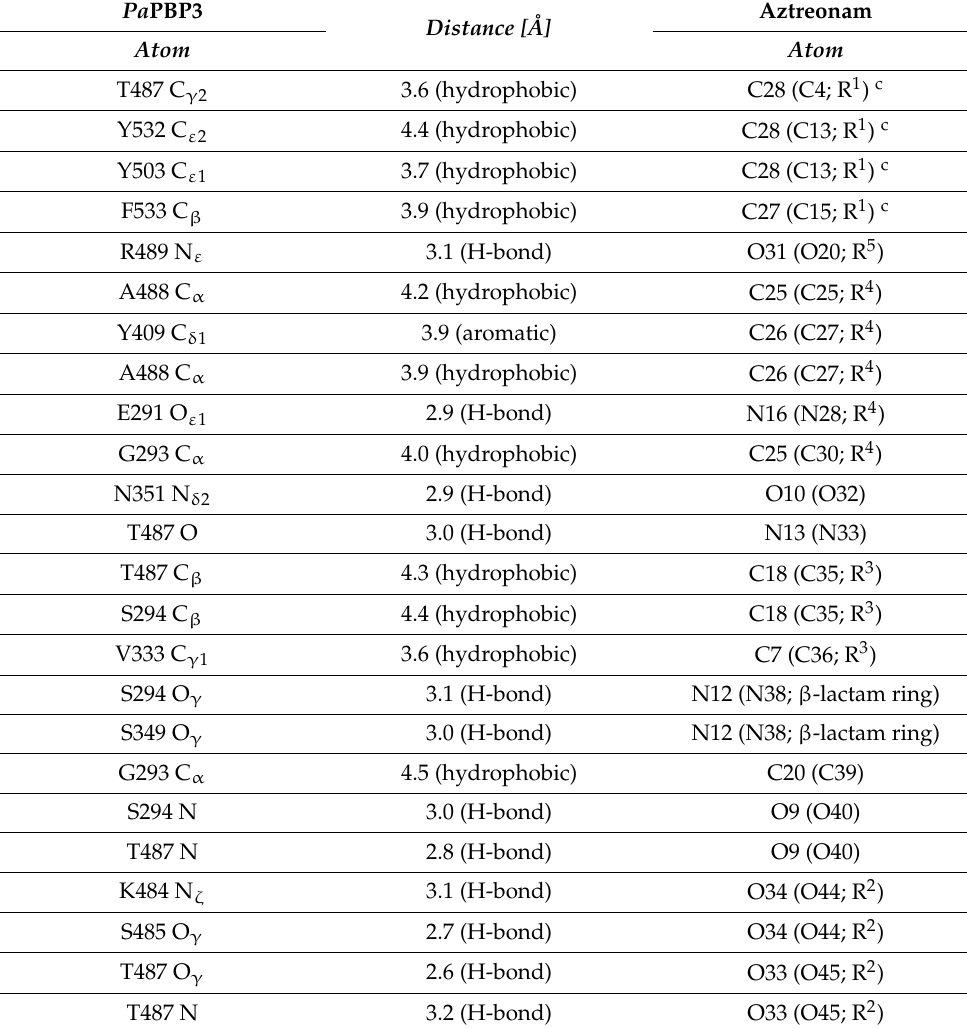
Table A2. Overview of the distances between atoms of aztreonam and Pa PBP3 (PDB entry 3PBS [11]), with type of interaction given in parentheses. Aztreonam atoms are named in accordance to PDB entry 3PBS, and equivalent atoms of AIC499 together with the respective functional groups are shown in parentheses. Hydrogen bonds are included with donor-acceptor distances ranging from 2.3 to 3.2 Å, and hydrophobic and aromatic interactions are listed for distances between 3.0 and 4.5